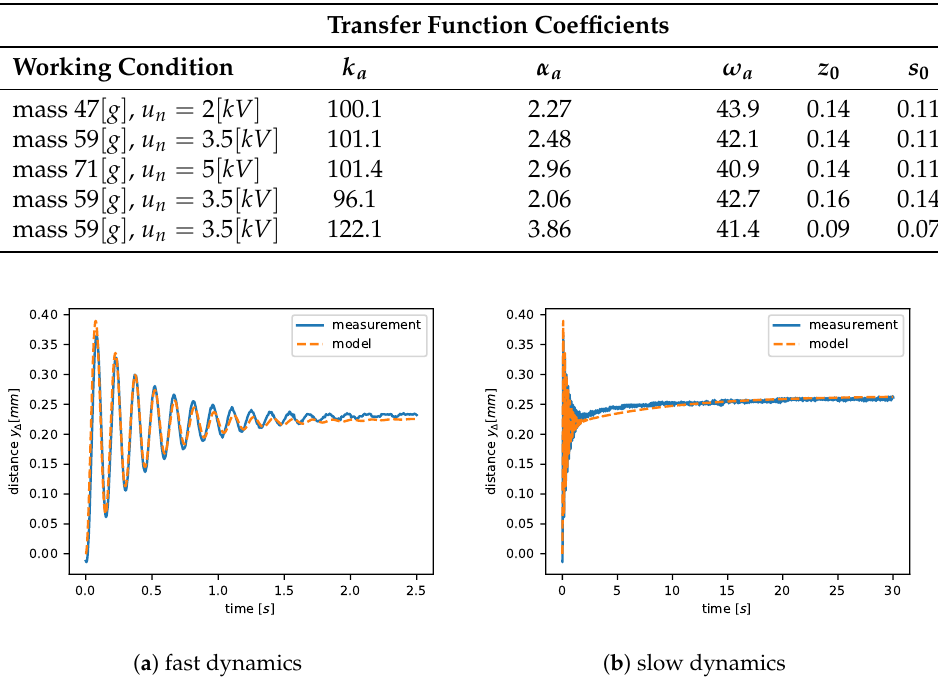
Figure 10. A comparison of the identified model with